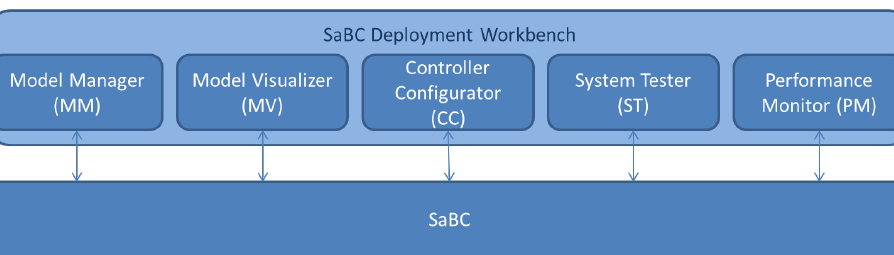
Figure 2. Workbench modular